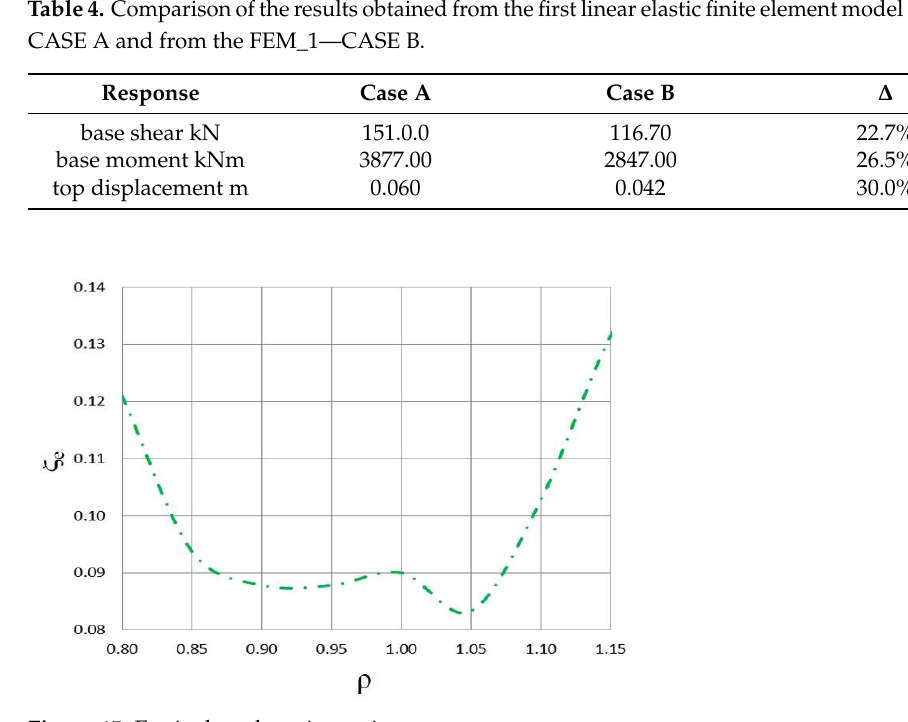
Figure 17. Chimney capacity curve. Figure 18. Crushing of the upper edge of the section base due to exceeding the compressive strength. Considering Step ult, the correspondence point on the moment-curvature (M-χ) diagram of each section of the chimney are determined to obtain the scale factor to be